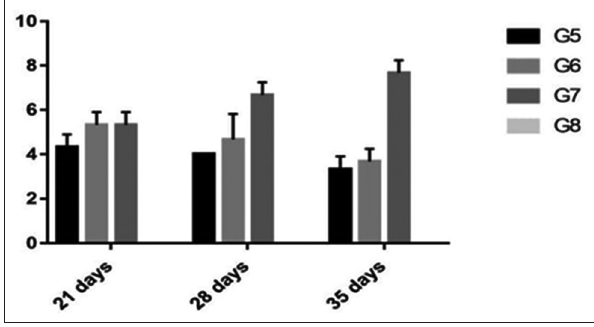
Figure-2: Column chart showing serum hemagglutination inhibition titer of Newcastle disease virus (expressed as log 2). Table-4: The score of pathological lesions for all groups in experiment